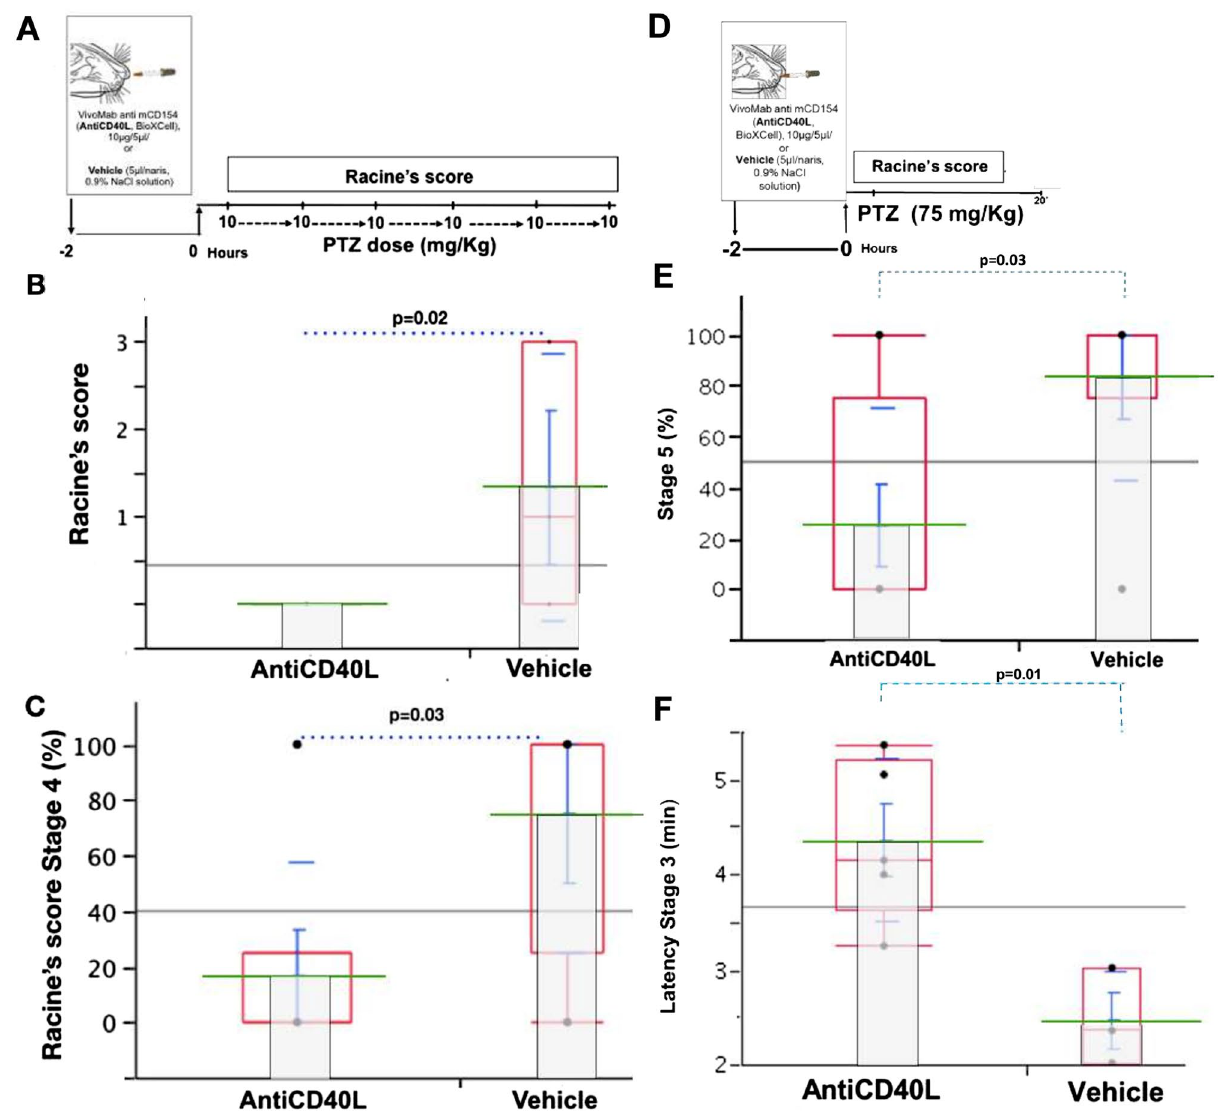
Figure 5. Intranasal administration of anti-mouse CD40L limits seizure susceptibility and seizure severity. ( A ) Experimental design to test anti-CD40 in an in vivo model of seizure susceptibility. Anti-CD40 (BioXCell InVivoMAb anti-mouse CD40L (CD154) or vehicle (sterile saline) was administered intranasally two hours before seizure induction with PTZ. ( B ) Anti-CD40L (n = 6) administration reduces Racine’s score compared to vehicle (n = 4) at 1st, 2nd, and 4th dose of PTZ ( p = 0.02). ( C ) Anti-CD40L administration decreases the severity of seizures compared to vehicle treatment, as measured by Racine’s score ( p = 0.03). ( D ) Experimental design to test anti-CD40 within in vivo model of severe seizures. Anti-CD40 ((BioXCell InVivoMAb anti-mouse CD40L (CD154)) or vehicle (sterile saline) were administered intranasally two hours before seizure induction with PTZ. ( E ) AntiCD40L reduces stage 5 seizure severity compared to vehicle. ( F ) AntiCD40L increases latency for stage 3 seizure in AntiCD40 (n = 8) compared to Vehicle (n = 6); p = 0.03 and p = 0.01. Data in graphics show individual values (black dots), mean (green line); standard error mean (S.E.M., blue bar), Standard deviation (blue line) and quartile (red